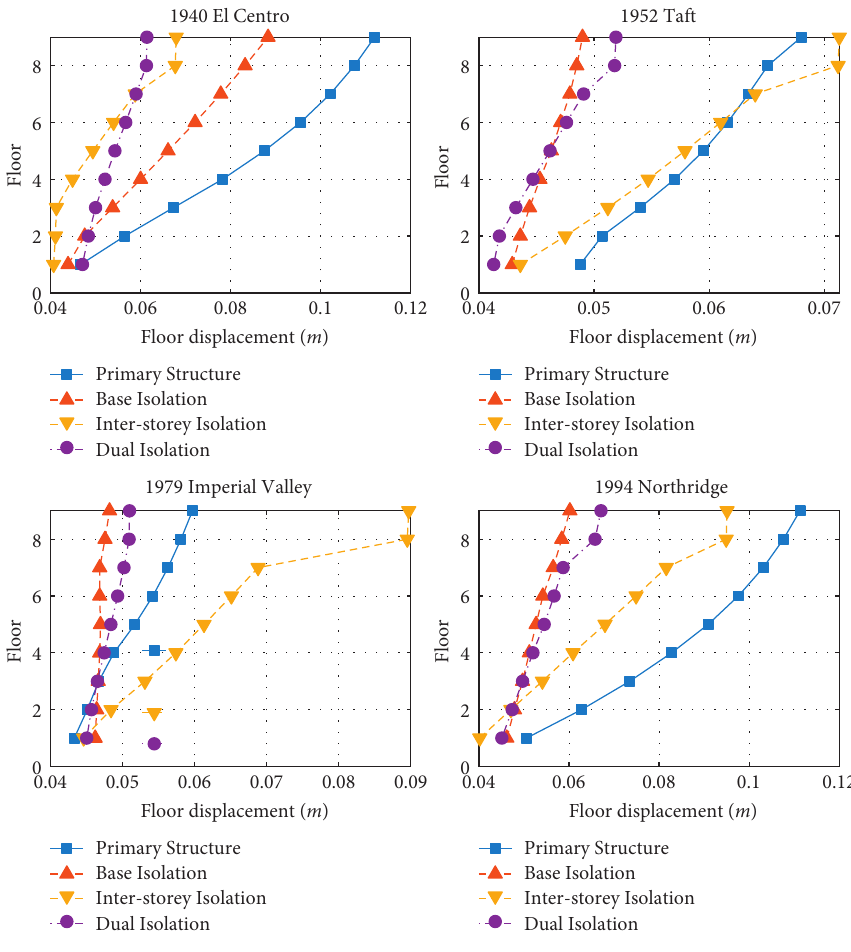
Figure 13: Floor displacement curve.